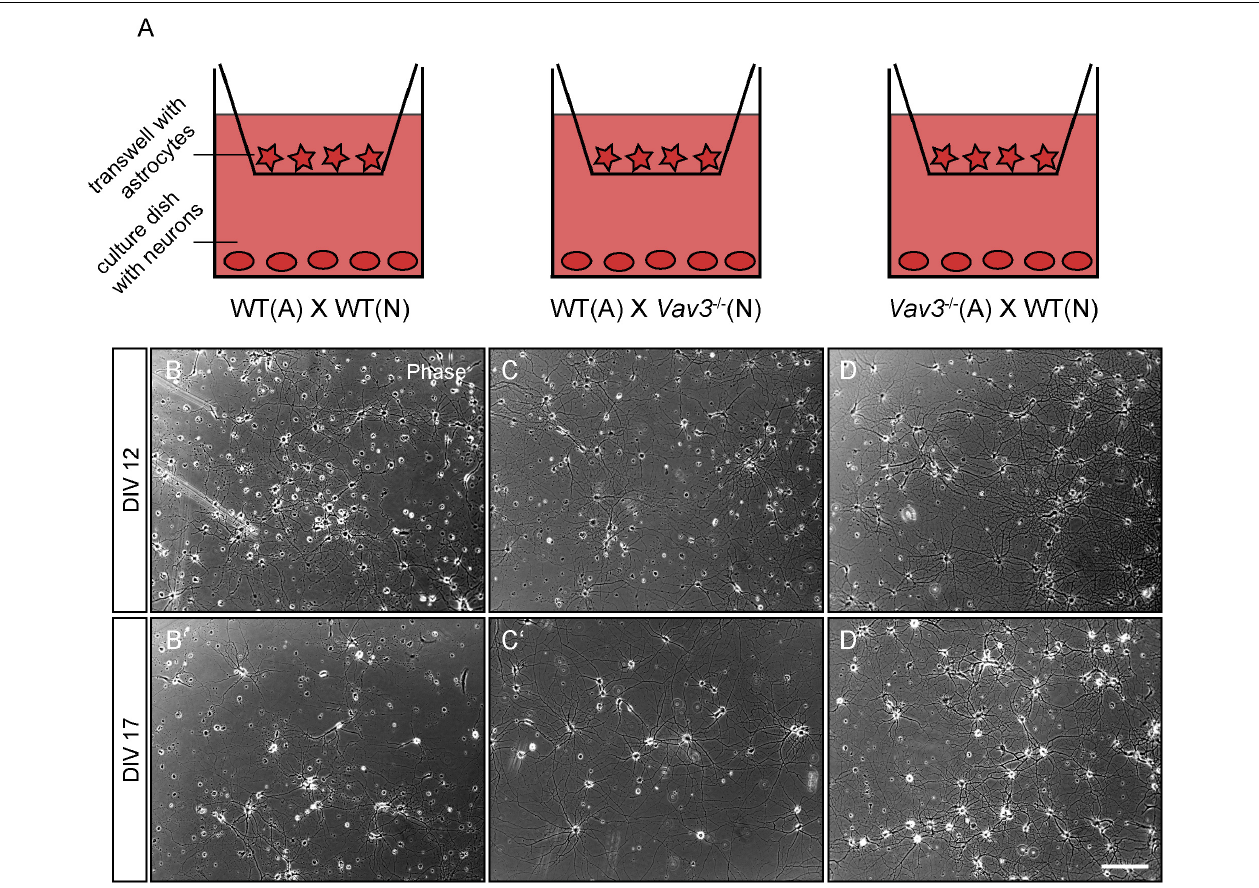
FIGURE 1 | (A) Primary hippocampal neurons were cultured in an indirect co-culture setup with cortical astrocytes. In order to analyze the influence of a Vav3 deficiency in neurons and astrocytes, different combinations of Vav3 knockout neurons and astrocytes were used. First, wildtype neurons were cultured with wildtype astrocytes and served as the control condition. Furthermore, Vav3 − / − neurons were combined with wildtype astrocytes for the analysis of neuron-specific effects induced by the Vav3 knockout. Last, wildtype neurons were cultured with Vav3 − / − astrocytes to investigate possible positive or negative effects for native neurons. (B–D) Neurons were kept in culture for 12 days in completely defined medium without serum and formed a highly complex network. Native neurons cultured with Vav3 − / − astrocytes appeared slightly more complex in comparison to the other culture combinations. (B’–D’) Additionally, neurons were cultured for a longer culturing time of 17 days since the dendrites become longer and more complex at this point in time. Scale bar: 200 µ m.